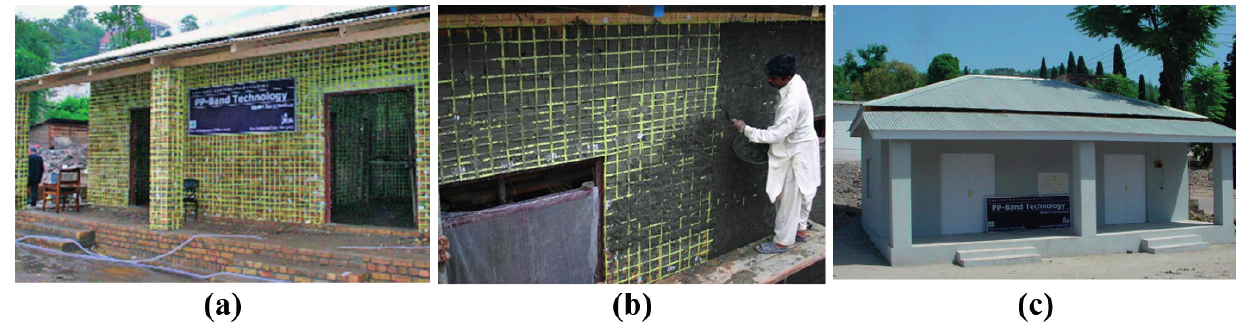
Figure 10. Application of PP-band retrofitting technology in Pakistan, ( a ) PP-band retrofitted house, ( b ) plastering of PP-band retrofitted house, and ( c ) surface Finished PP-band retrofitted house